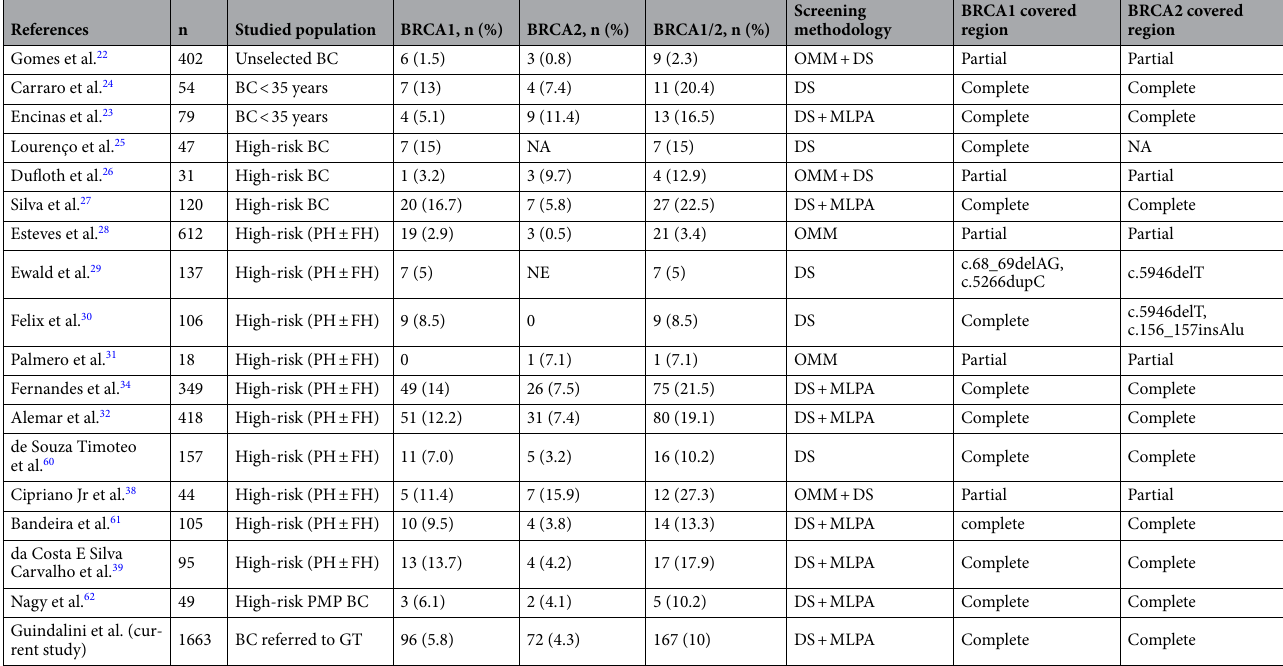
Table 3. Prevalence of BRCA1/2 germline variants in HBOC patients in Brazil. BC breast cancer, PH ± FH personal history and / or family history of breast and / or ovary cancer, PMP postmenopausal, GT